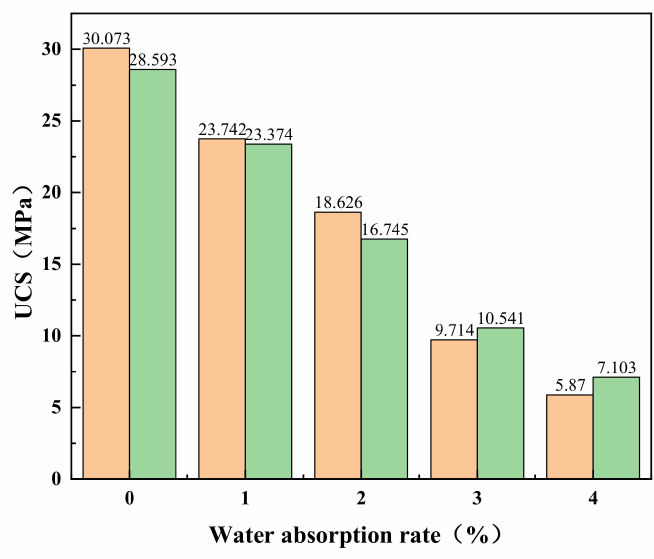
Figure 7. UCS with different moisture absorption